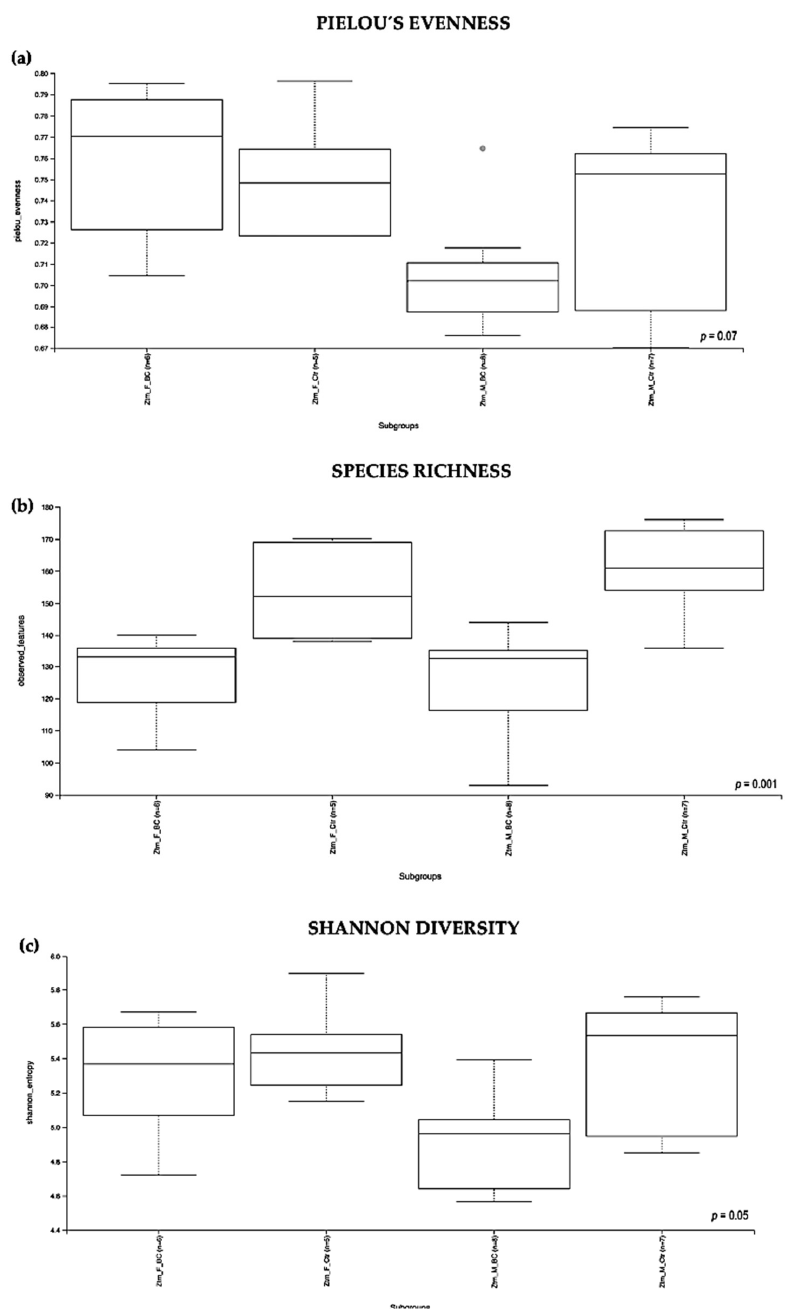
Figure 3. Alpha diversity of the intestinal microbial communities between Ztm BC and control groups post BC treatment. Comparison of boxplots depicting Pileou´s evenness ( a ), species richness ( b ), and Shannon diversity ( c ). Diversity among Ztm f BC ( n = 6), Ztm f Ctr ( n = 5), Ztm m BC ( n = 8), and Ztm m Ctr ( n = 7) groups. p < 0.05 indicating that the alpha diversity between groups is significant. p values = Kruskal–Wallis rank-sum test (all groups). WT = wild-type mice; BC = bovine colostrum treatment; Ctr = control mice; f = female; m = male; n = number of mice in a group.